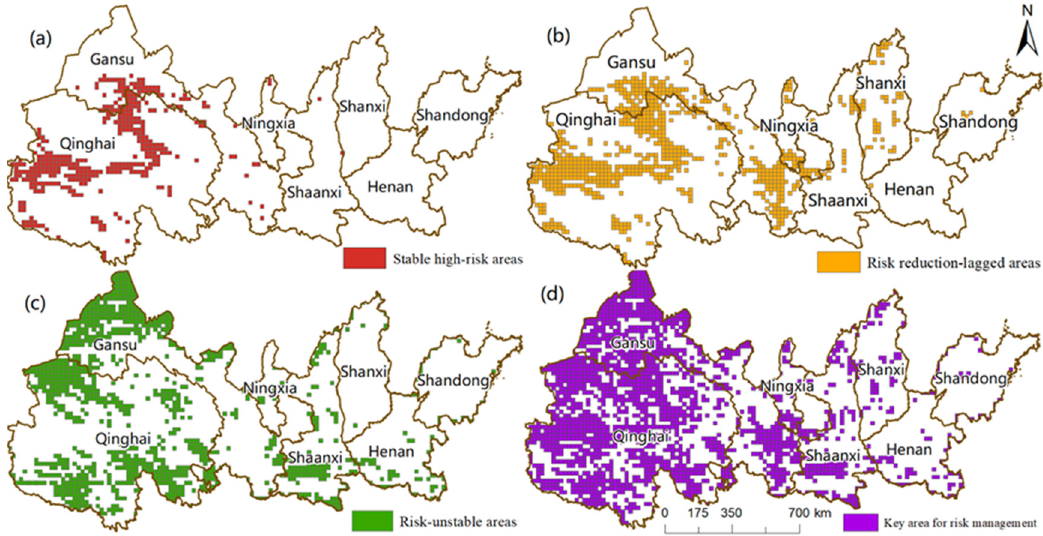
Figure 9. The spatial configuration of risk management. stable high-risk areas ( a ), risk reduction-lagged areas ( b ), risk-unstable areas ( c ), and key areas for risk management ( d ).